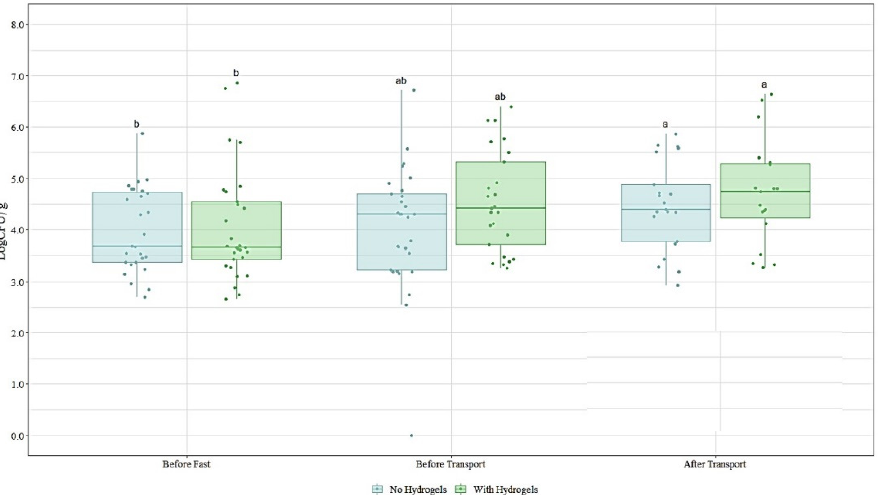
Figure 2. E. coli enumeration from fecal samples. Treatment group ( n = 21) was supplemented with hydrogel beads during transportation (blue bars) and control groups ( n = 21) did not have access to the beads (green bars). Significant differences ( p < 0.05) are represented with different letters. Samples were collected at each established point: Before Fast ( n =59), Before Transport ( n =60), and After Transport ( n =49).